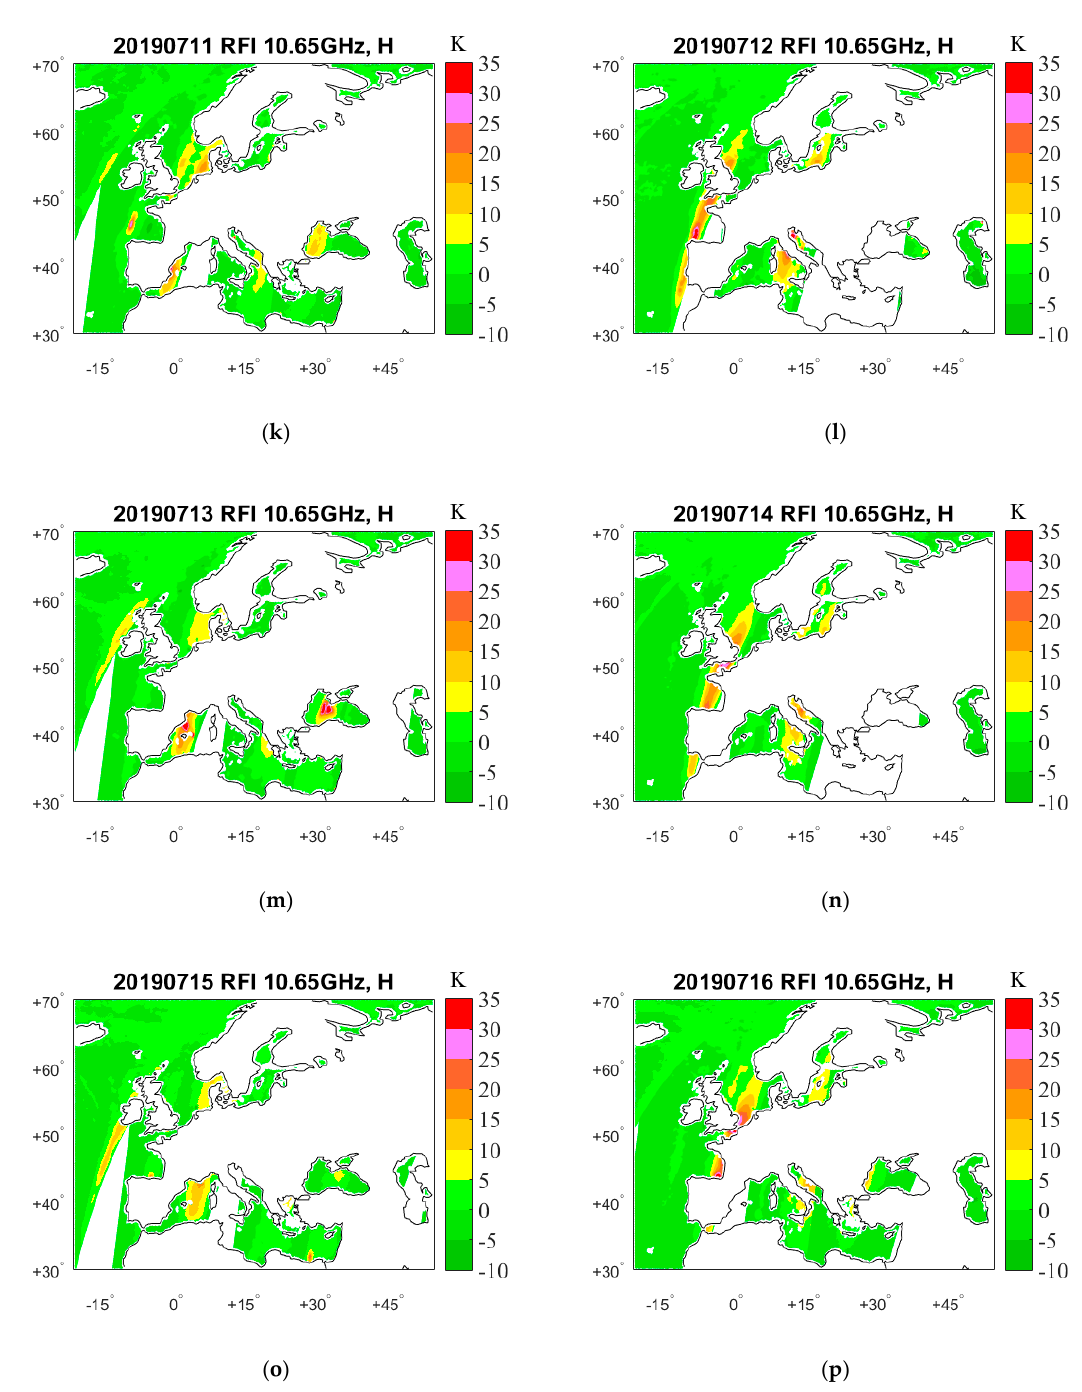
Figure 4. Spatial distribution of 10.65 GHz-H RFI, using GRDM over European waters during the period 1–16 July 2019. ( a ) 1 July; ( b ) 2 July; ( c ) 3 July; ( d ) 4 July; ( e ) 5 July; ( f ) 6 July; ( g ) 7 July; ( h ) 8 July; ( i ) 9 July; ( j ) 10 July; ( k ) 11 July; ( l ) 12 July; ( m ) 13 July; ( n ) 14 July; ( o ) 15 July; ( p ) 16 July.